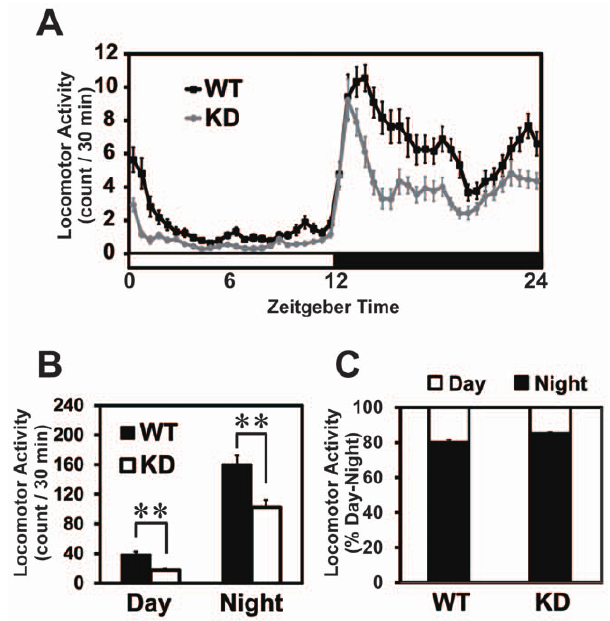
Figure 3. Reduced amount of locomotor activity in the Rgs16 KD mice. A, Averaged daily activity plot of the KD and WT mice under LD condition. B, Average daytime or nighttime locomotor activity was significantly decreased in the KD mice as compared to that of WT controls (n=21 each). ** P , 0.01 vs. WT (Student’s t -test). C Averaged day/night ratio of locomotor activity was comparable between the KD and WT mice (n=21 each).